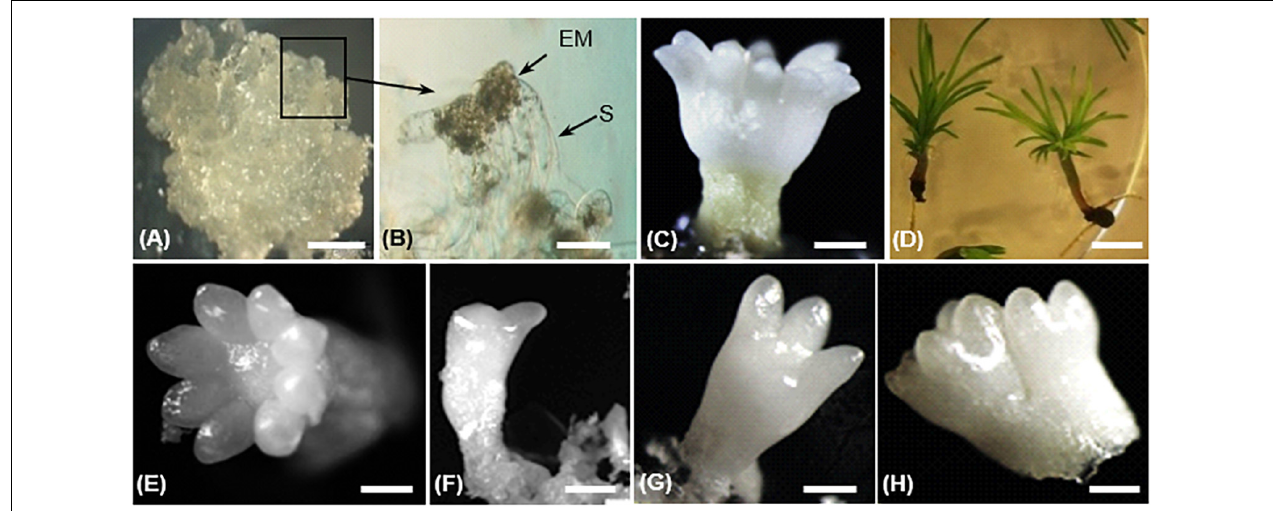
FIGURE 2 | Different steps of somatic embryo (SE) development in Pinus pinaster (A–D) and morphology of harvested cotyledonary SEs (E–H) in transgenic 35S::PpWOX2 lines and control lines (transgenic EV-pC05 line and the non-transgenic WT). (A) Embryogenic culture containing proliferating immature SE; (B) proliferating SEs showing embryo proper (EP) and suspensor cells (S); (C) cotyledonary SE after 14 weeks in maturation medium; (D) somatic seedlings after 8 weeks in conversion medium. Cotyledonary SEs from PpWOX2 and control lines were classified according to different categories such as (E) normal (cotyledons with symmetrical radial development), (F,G) deformed (cotyledons with asymmetrical development), and (H) not separated, fused embryos. Scale bars: (A) 3 mm, (B) 0.1 mm, (B,C,E–H) 2 mm, and (D) 5 mm.